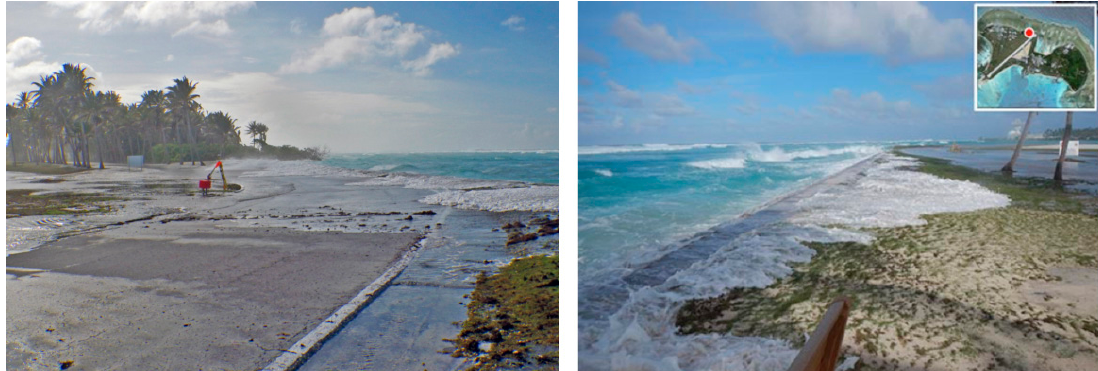
Figure 7. Photos of wave-driven flooding and overwash on Roi-Namur Atoll, Republic of the Marshall Islands near the north end of the runway. Photo on the left is looking west and photo on the right is looking east. Red dot on subplot (left photo) indicates the photos location on Roi-Namur.